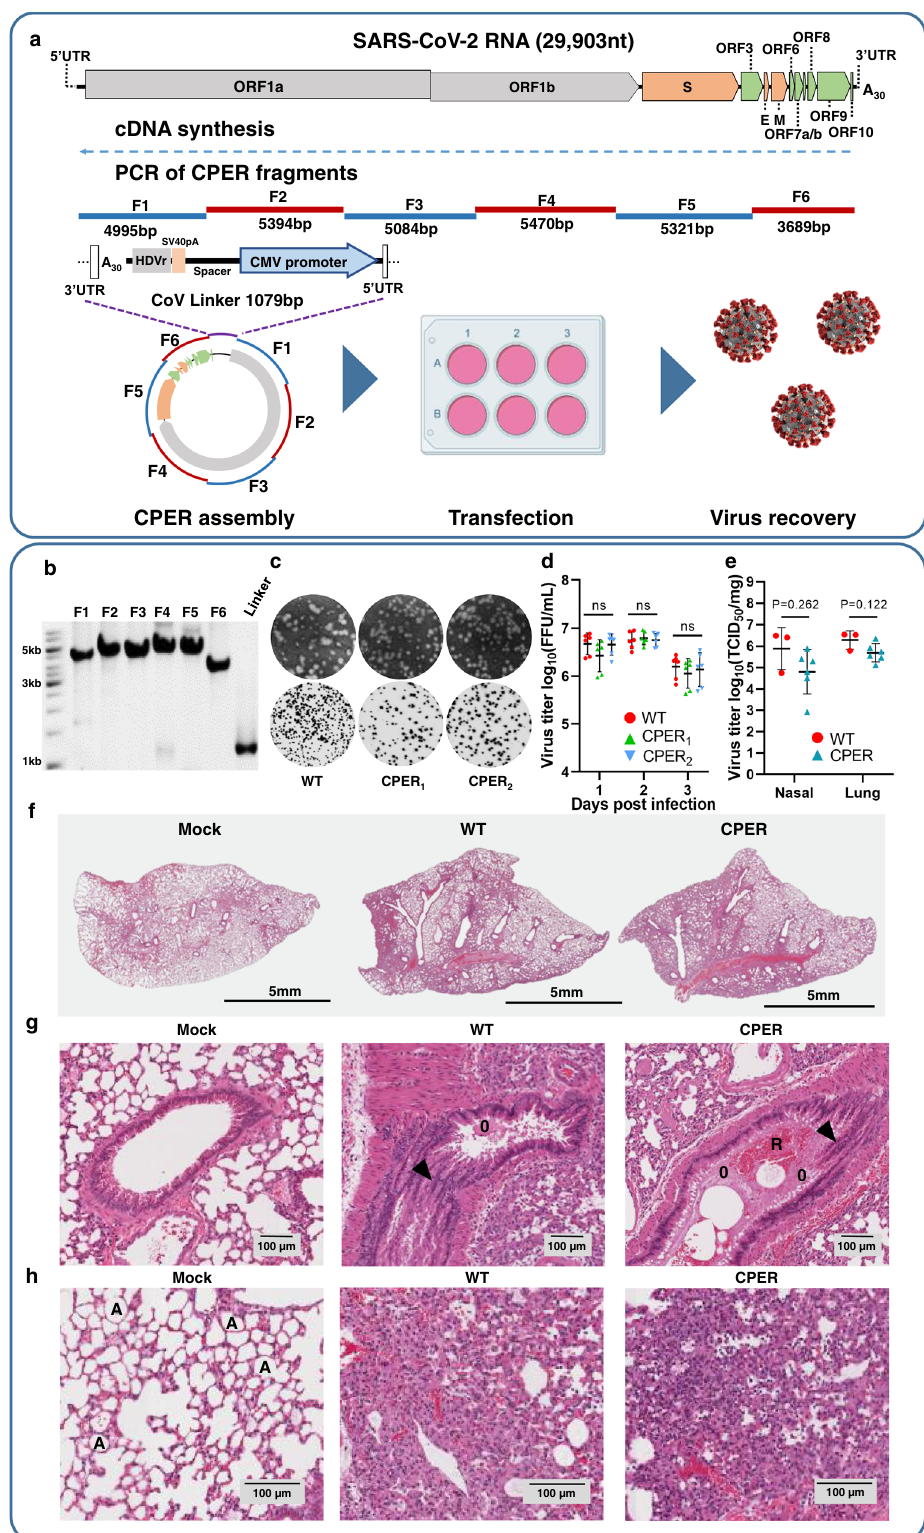
To examine viral properties in cells, a standard plaque assay with crystal violet staining of infected cells at 2 days post infection (dpi) was performed and showed similar plaque sizes for CPER1 and CPER2 viruses and the parental WT QLD02 isolate (Fig.